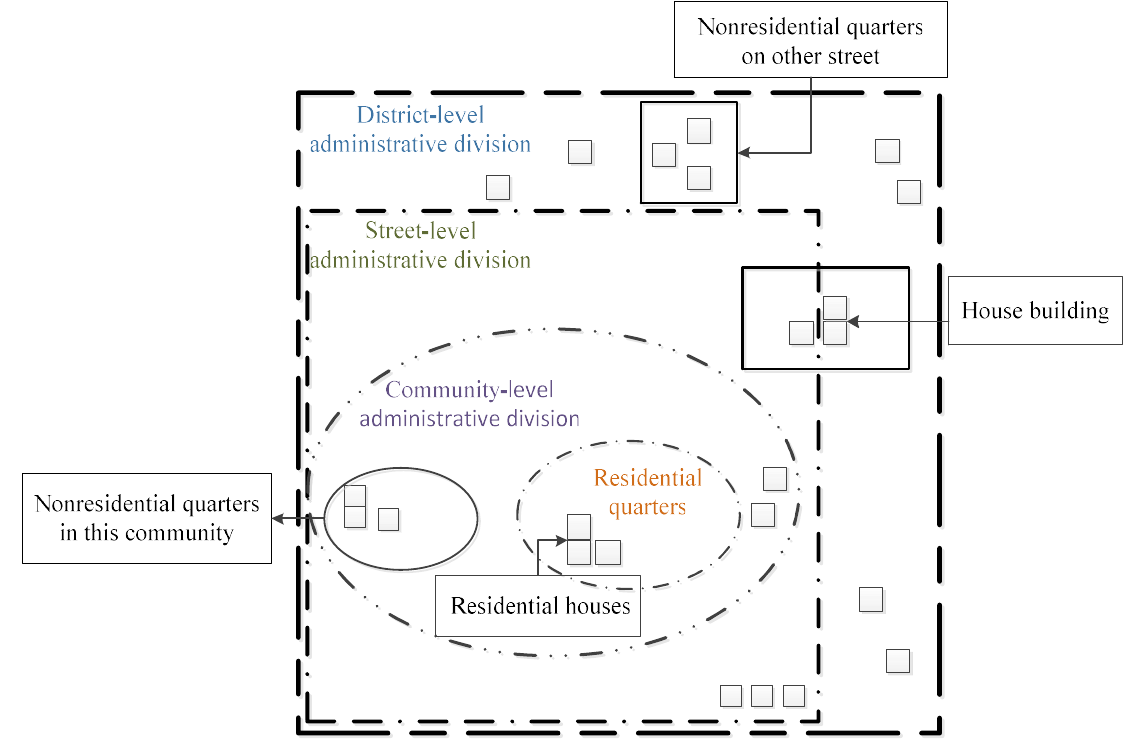
Figure 1. Schematic Diagram of Data Preprocessing.